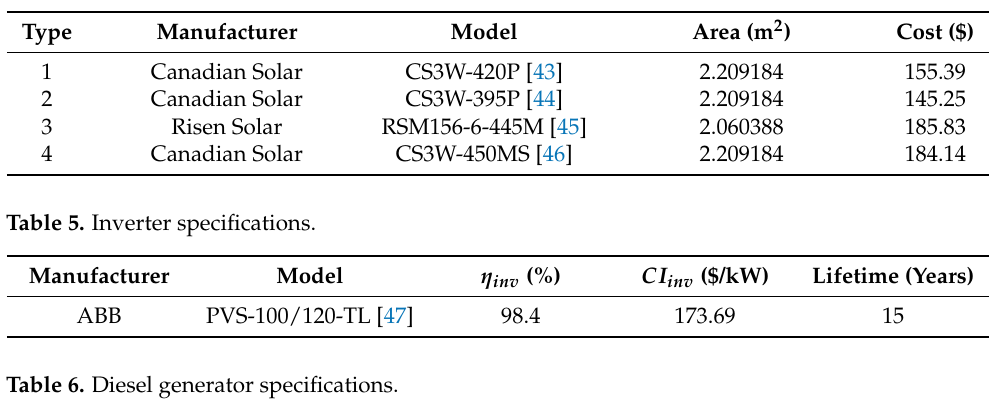
Table 4. PV panels specifications.